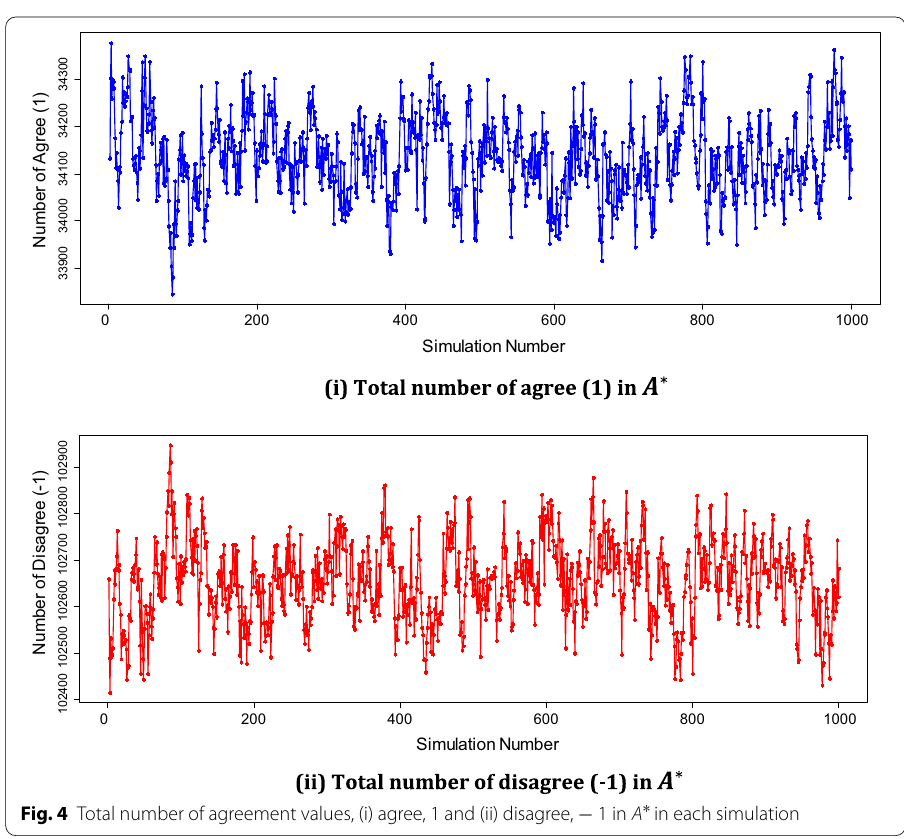
Fig. 4 Total number of agreement values, (i) agree, 1 and (ii) disagree,